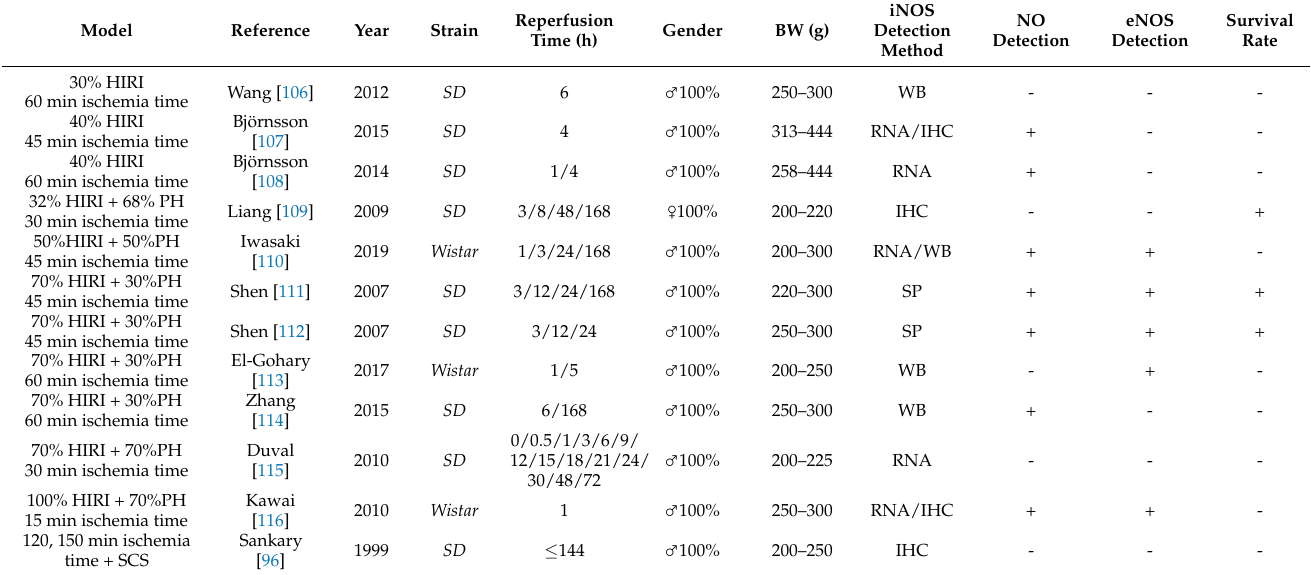
Table 3. Overview of other rat models (not included in the meta-analysis).